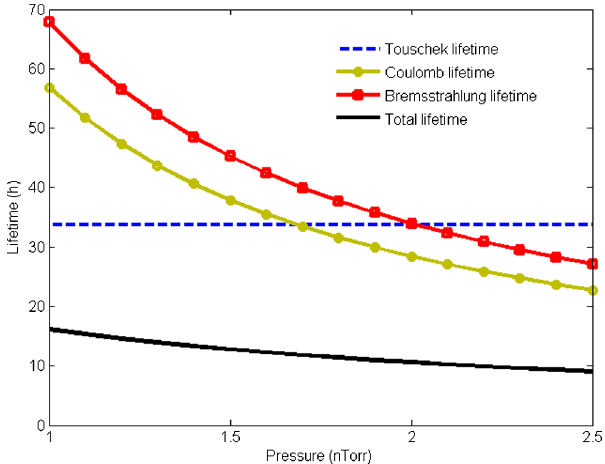
FIG. 20. Lifetime in the storage ring versus pressure within the pipe. Momentum acceptance is